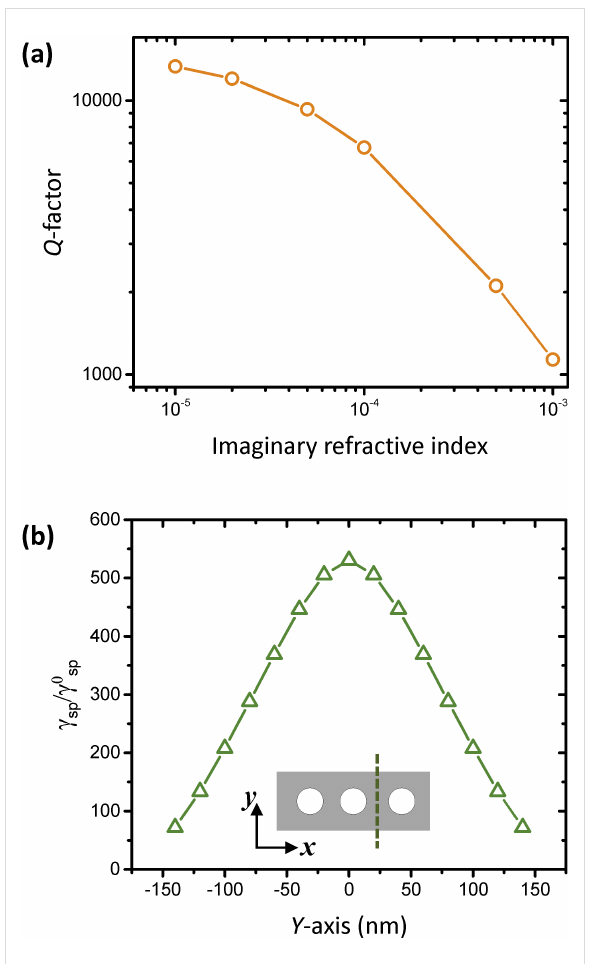
Figure 4: (a) Q -factor of the fundamental mode in a 1D photonic crystal cavity versus the imaginary refractive index coefficient of the material. (b) Spontaneous emission rate enhancement of a dipole emitter plotted as a function of distance across the 1D photonic crystal nanobeam